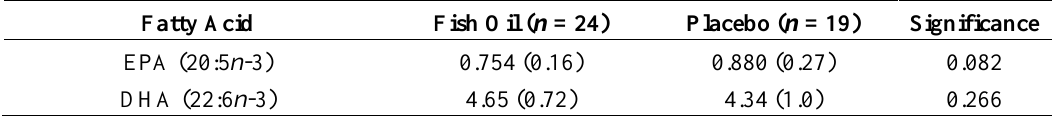
Table 3. Difference in n -3 LCPUFA at 12 years according to supplementation group during pregnancy.